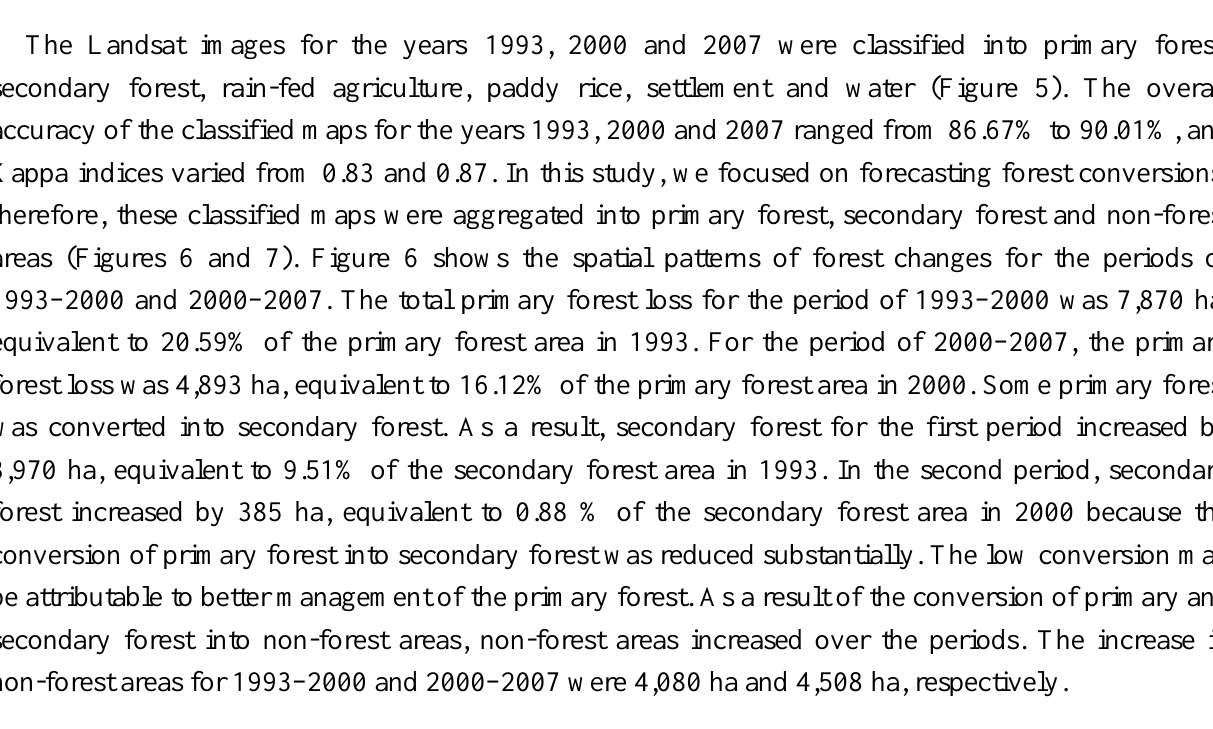
Figure 5. Land-use maps derived from Landsat in 1993, 2000 and